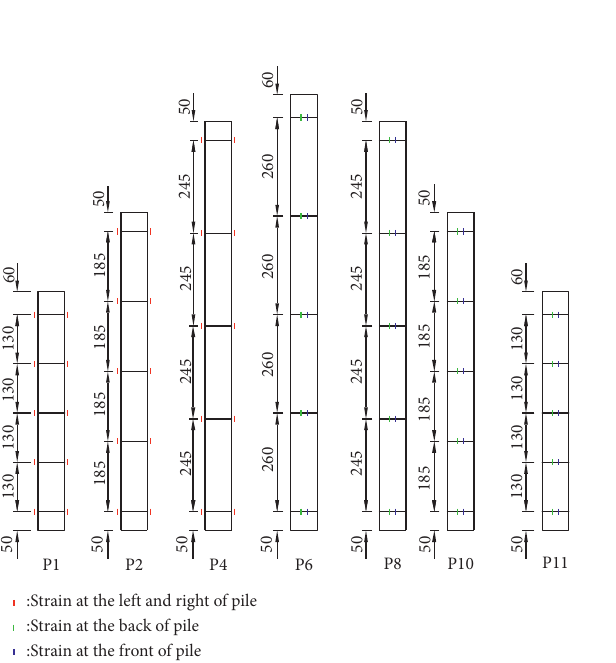
Figure 18: Layout of strain gauge (mm).